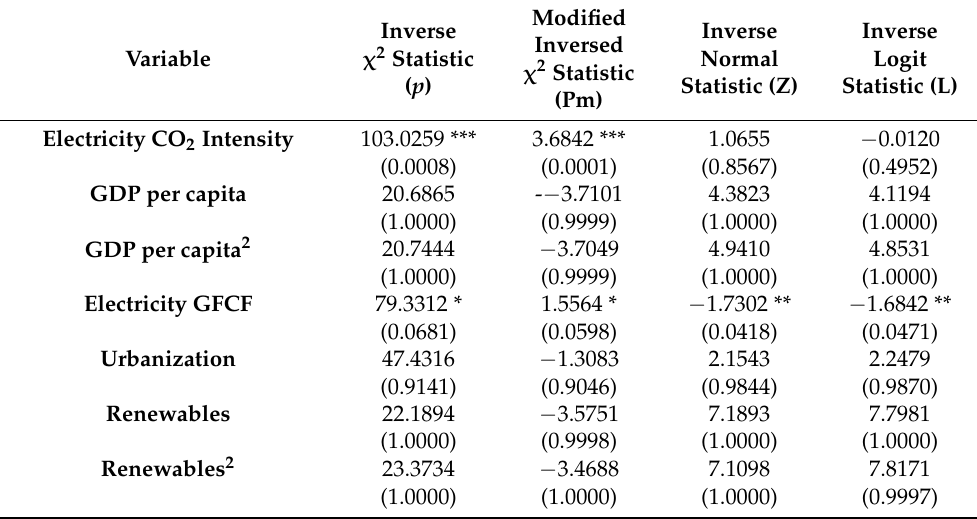
Table 6. ADF–Fisher panel unit root test at level I(0).